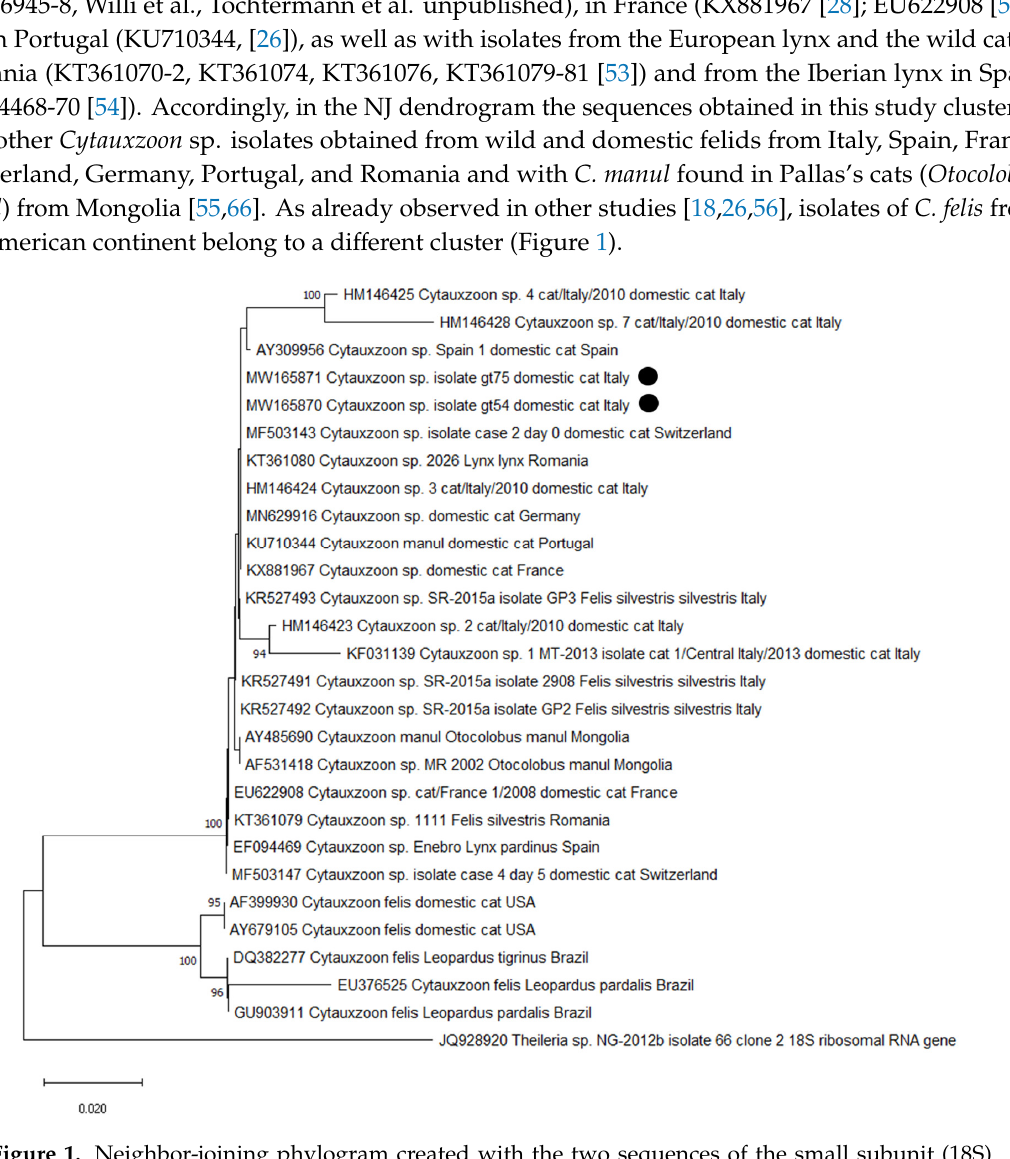
Figure 1. Neighbor-joining phylogram created with the two sequences of the small subunit (18S) ribosomal RNA gene obtained in the present survey (highlighted with a black dot), 20 sequences of Cytauxzoon sp., and five sequences of Cytauxzoon felis from other studies in domestic and wild animals.